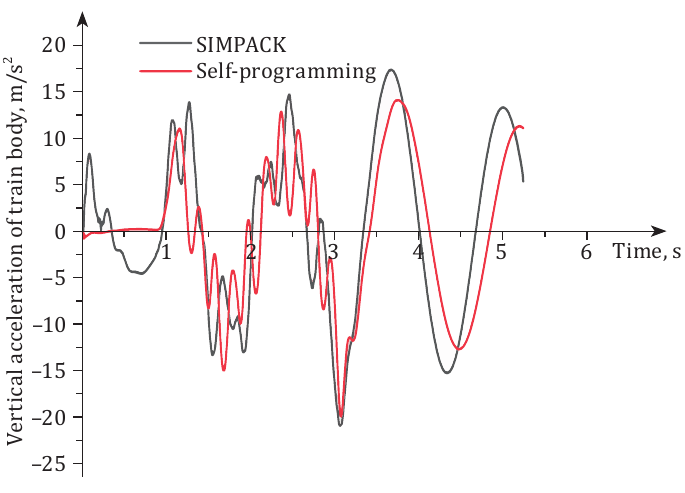
Figure 12. Comparison of vertical acceleration time history at the